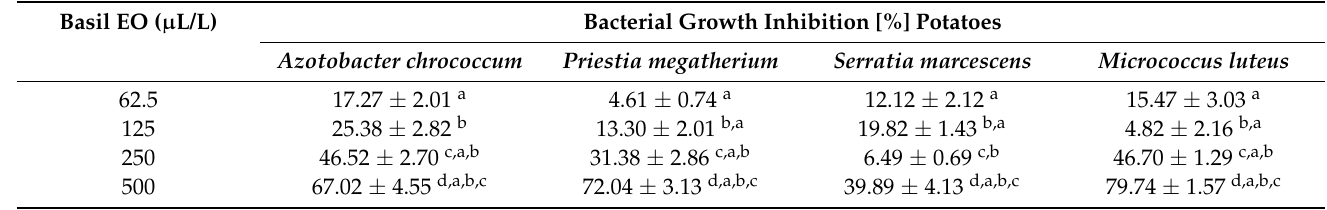
Table 8. In situ analysis of the antibacterial activity of the vapor phase of OBEO on